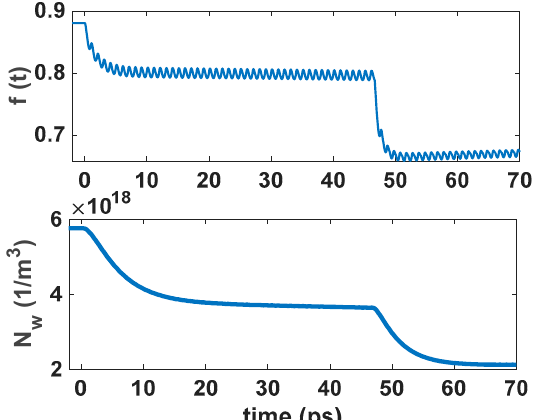
Figure 8. The GS and WL dynamics for a 5 Tb s − 1 input bit sequence in the OP method. The input signal power is 20 mW.